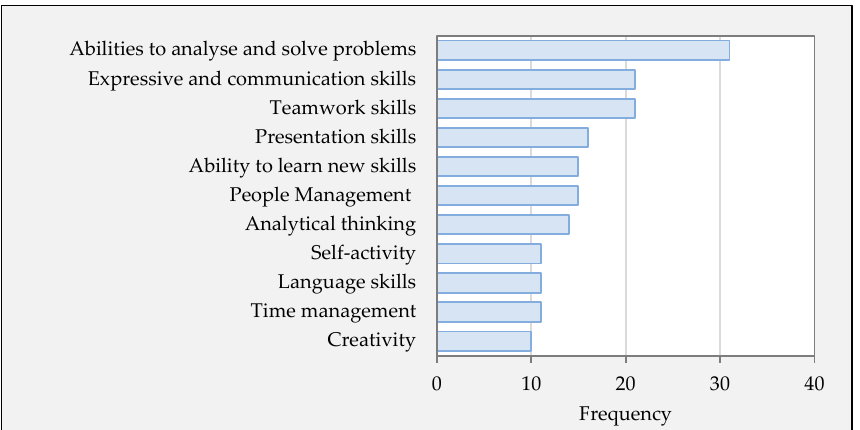
Figure 12. The skills developed in the Statistics course.